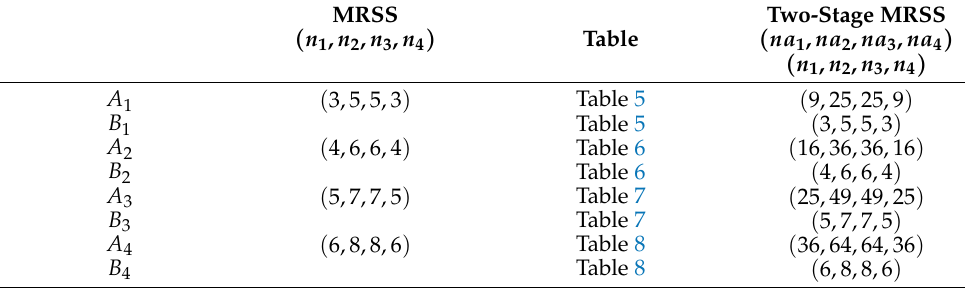
Table 4. Details of different sample sizes for simulation study.